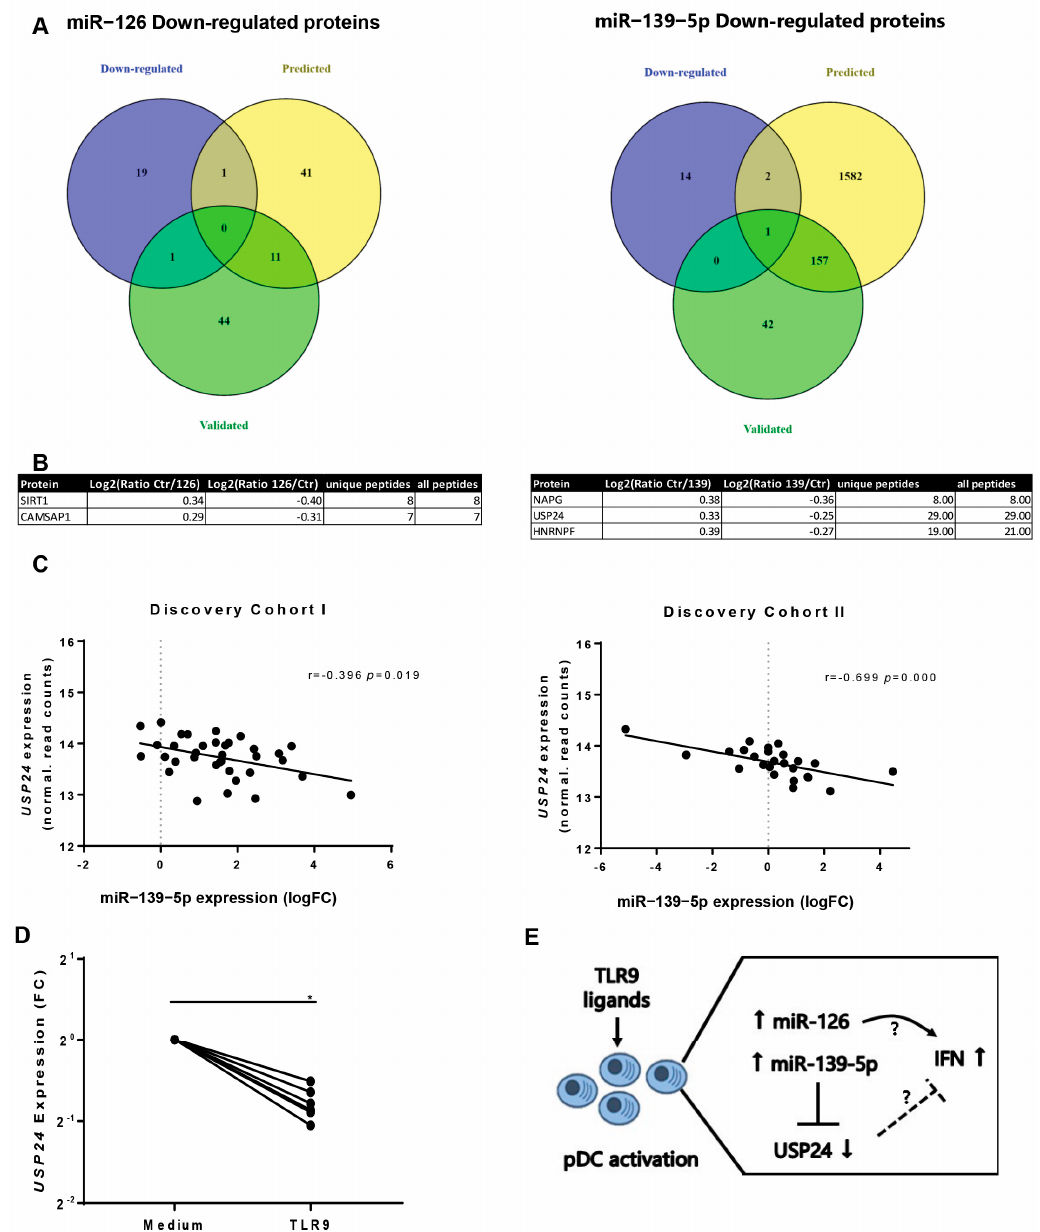
Figure 5. Proteomic analysis to identify the direct targets of miR-126 and miR-139-5p. Stable isotope labeling of amino acids (SILAC) followed by proteomic analysis was performed to identify the targets of miR-126 and miR-139-5p. Only protein targets modulated (log2[ratio miRNA/Ctr] < − 0.25 and log2[ratio Ctr/miRNA] > 0.25) in two different biological and technical replicates were taken into consideration. ( A ) Intersection between the down-regulated targets from proteomics analysis (purple circle), the pure predictions of the miRNA in at least three bioinformatic softwares (yellow circle), and the experimental supported or validated targets of the miRNAs (green circle). ( B ) Table depicting the direct protein targets of miR-126 and miR-139-5p filtered out from the intersection of proteomics and predicted and validated targets. ( C ) Correlation of the USP24 gene expression with miR-139-5p in discovery cohort I and in discovery cohort II (Spearman’s correlation p < 0.05). ( D ) PDCs of six independent healthy controls ( n = 6) were stimulated for 24 h with Toll-like receptor 9 (TLR9) ligand, and the expression of USP24 was assessed by single qPCR. The expression is presented as Fold Change (FC) as compared to the mean expression of the control medium group. Data were normalized to the expression of GUSB and analyzed with the Wilcoxon signed-rank test ( p < 0.05). * indicates p -value < 0.05. ( E ) Hypothesis model: Putative functional implication of dysregulated miRNAs in SSc pDCs. The chronic activation of pDCs in SSc patients, possibly due to either endogenous or exogenous ligands, leads to an increase of miR-126, which can functionally support IFN response. In parallel, pDC activation promotes also the upregulation of miR-139-5p, which in turn targets USP24, a potential inhibitor of IFN response, thus finally leading to a further potentiation of this